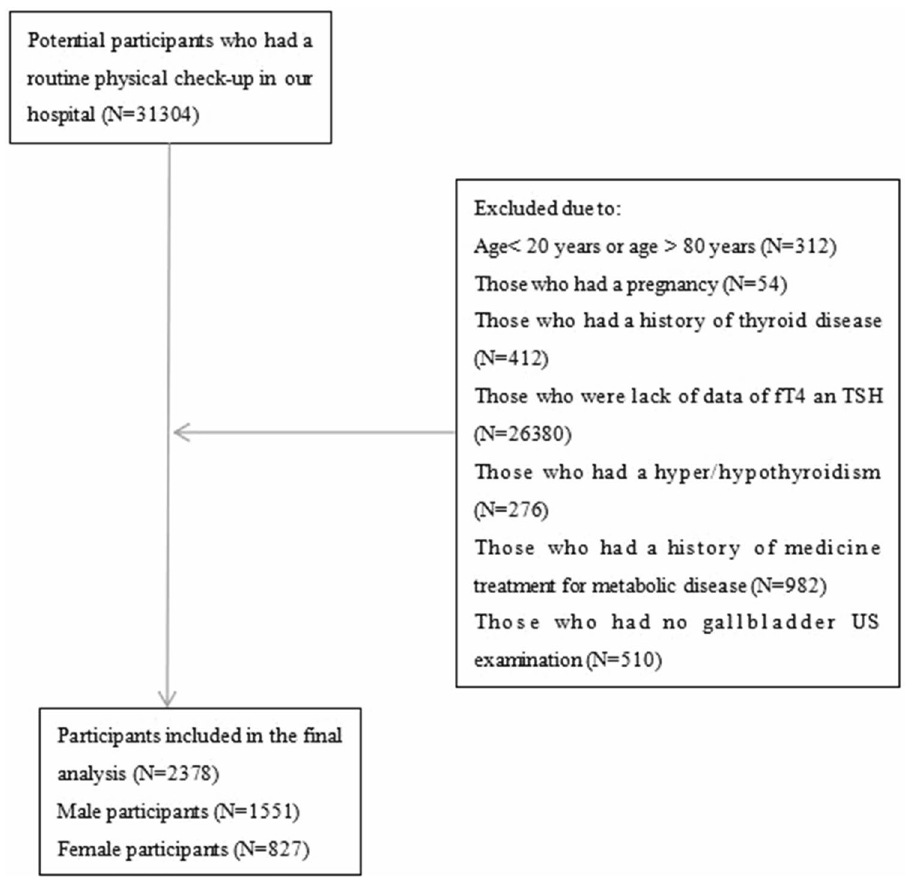
Figure 2. Flow chart of the